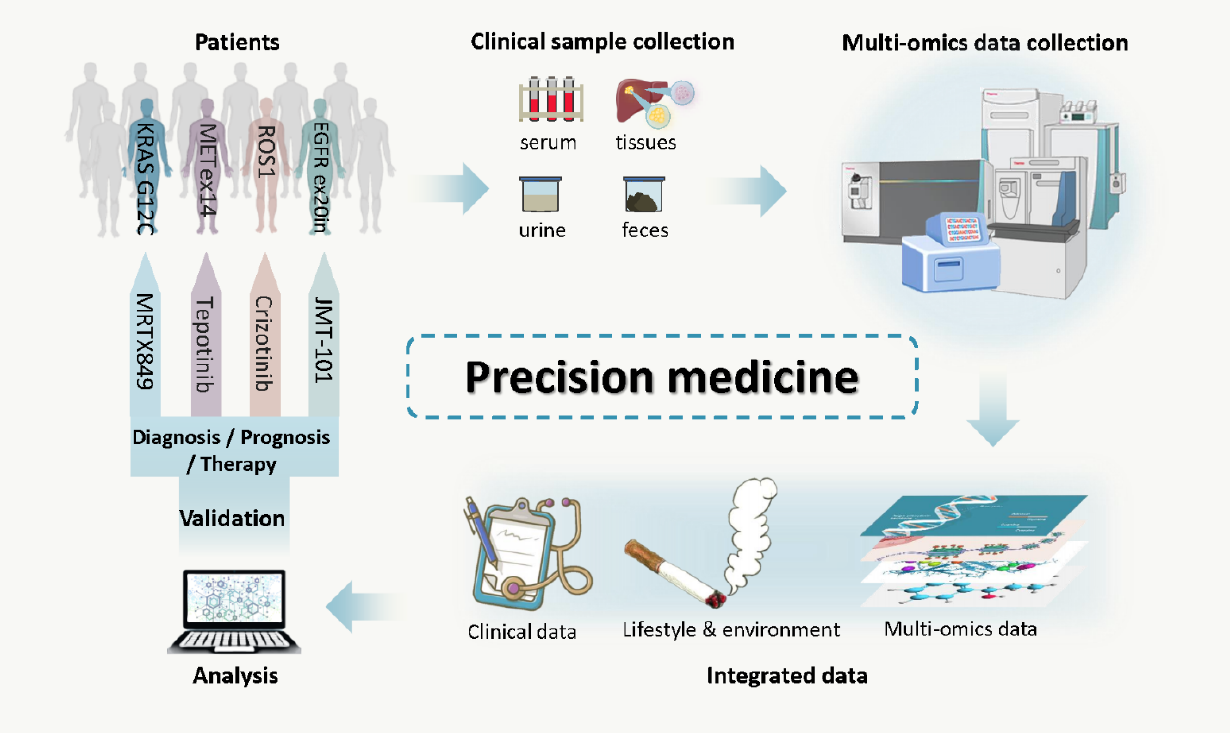
Figure 1. Precision medicine. Samples (e.g., serum/tissue/urine/feces) can be analyzed by multiomics technologies. Blood informs on the systemic response to the disease, urine includes the host metabolites which are excreted from the body, stool samples show what the intestine is exposed to and resected tissue can give information on the response mounted at the site of disease. Information from multiomics analyses, clinical reports, lifestyle and psychosocial characteristics can identify biomarkers for prevention, diagnosis, prognosis and surveillance, and help to determine the most suitable therapeutic schedule for individuals presenting with a given disease.